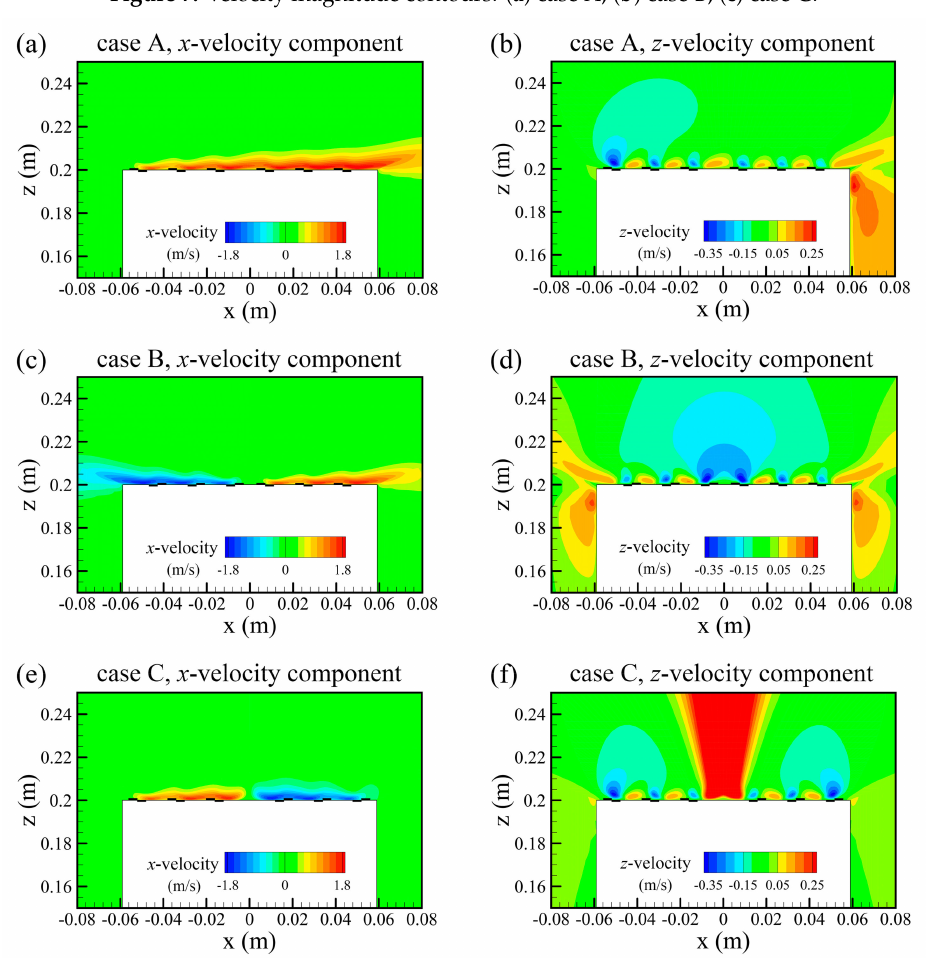
Figure 8. Velocity component contours: ( a , b ) case A; ( c , d ) case B; ( e , f ) case C.